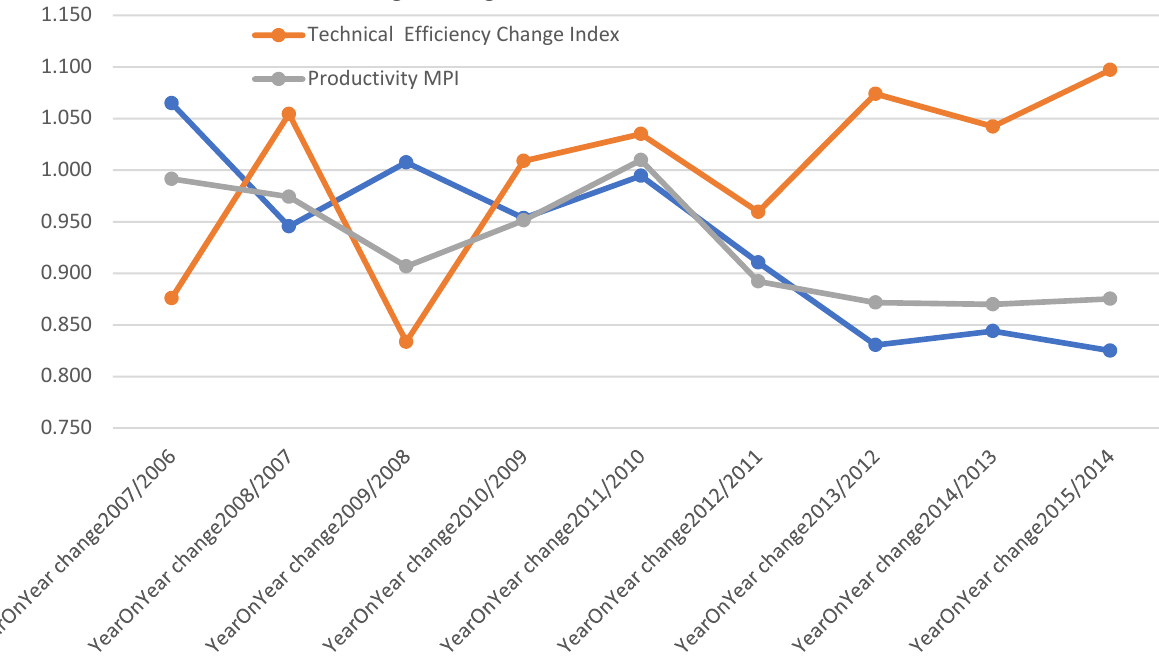
Figure 5. The trends of overall (average) year-on-year change of the Malmquist productivity index, technological change index, and technical efficiency change index for the total studied cities in Shanxi Province from 2006 to 2015.